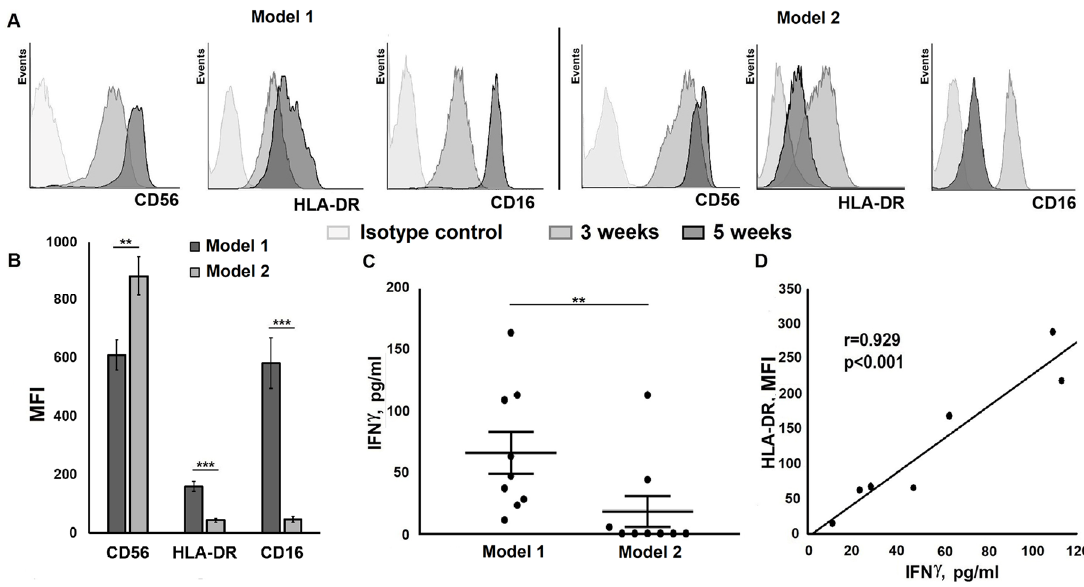
Figure 3. Expression of surface markers and interferon- γ (IFN- γ ) production by NK cell clones depends on the cultivation model. ( A ) Dynamics of surface markers expression in NK cell clones cultivated according to model 1 and model 2. Measurements were carried out at weeks three and five of cultivation. ( B ) Differences in the expression of CD56, human leukocyte antigen-DR isotype (HLA-DR), and CD16 in NK cell clones cultivated using models 1 and 2 (measurements were carried out at week 5). ( C ) Comparison of the level of IFN- γ in supernatants of clones cultivated according to models 1 and 2 (from 22 to 67 independent clones were analyzed in each type of measurement). ( D ) Correlation between HLA-DR expression level and IFN- γ production in clones cultivated using model 1. ( C , D ) Measurements were carried out at week four of clone cultivation. Significant differences are shown by asterisks as ** p < 0.01; *** p < 0.005.